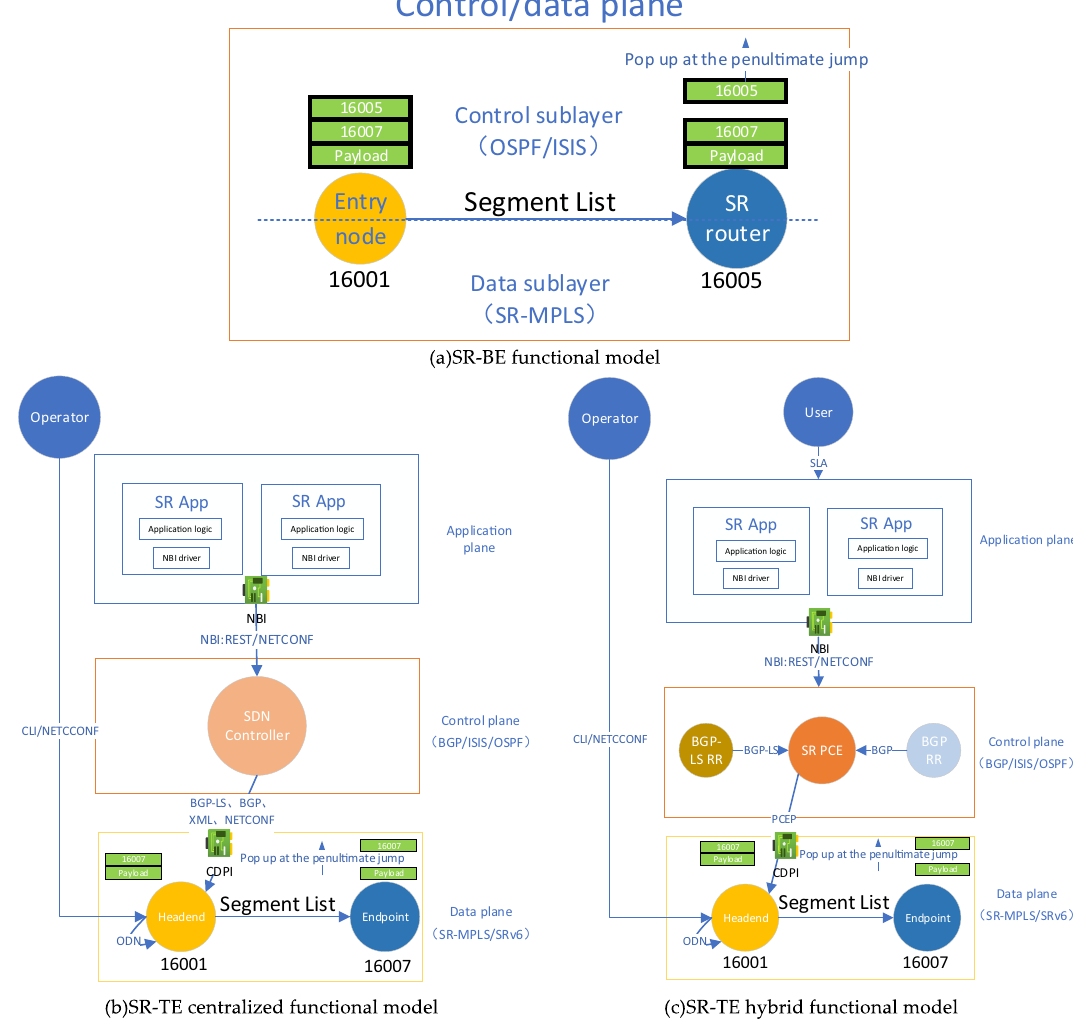
Figure 1. Typical SR function model.